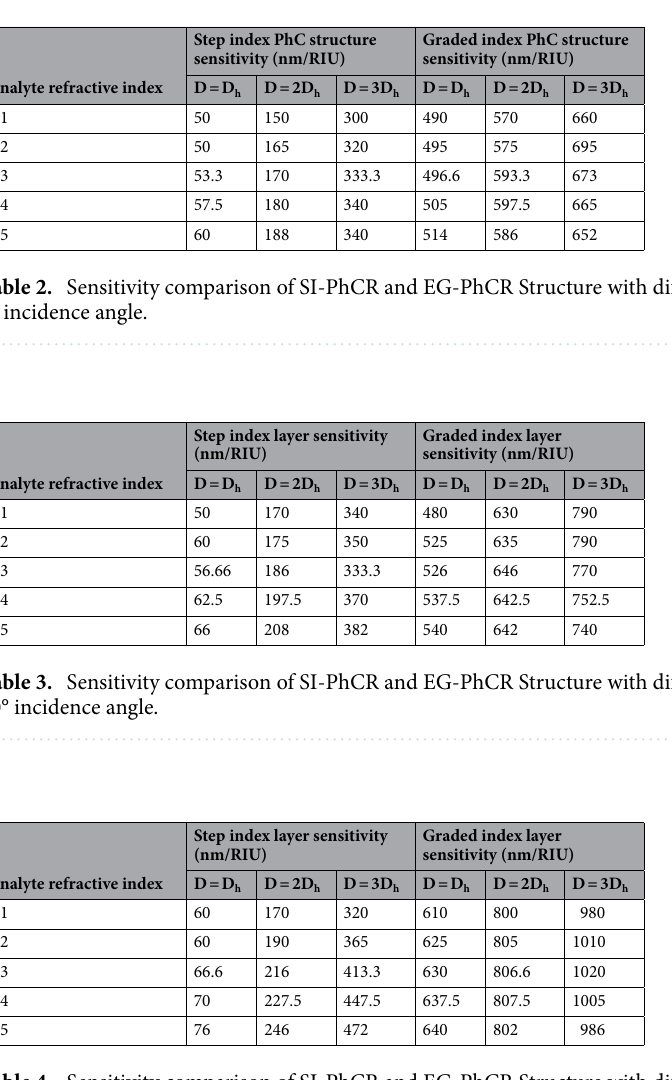
Table 4. Sensitivity comparison of SI-PhCR and EG-PhCR Structure with different defect layer thickness at a 40° incidence angle.